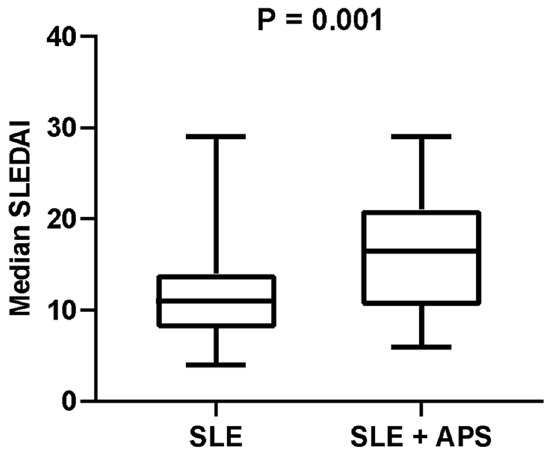
Fig. 3 SLEDAI score in SLE patients with and without